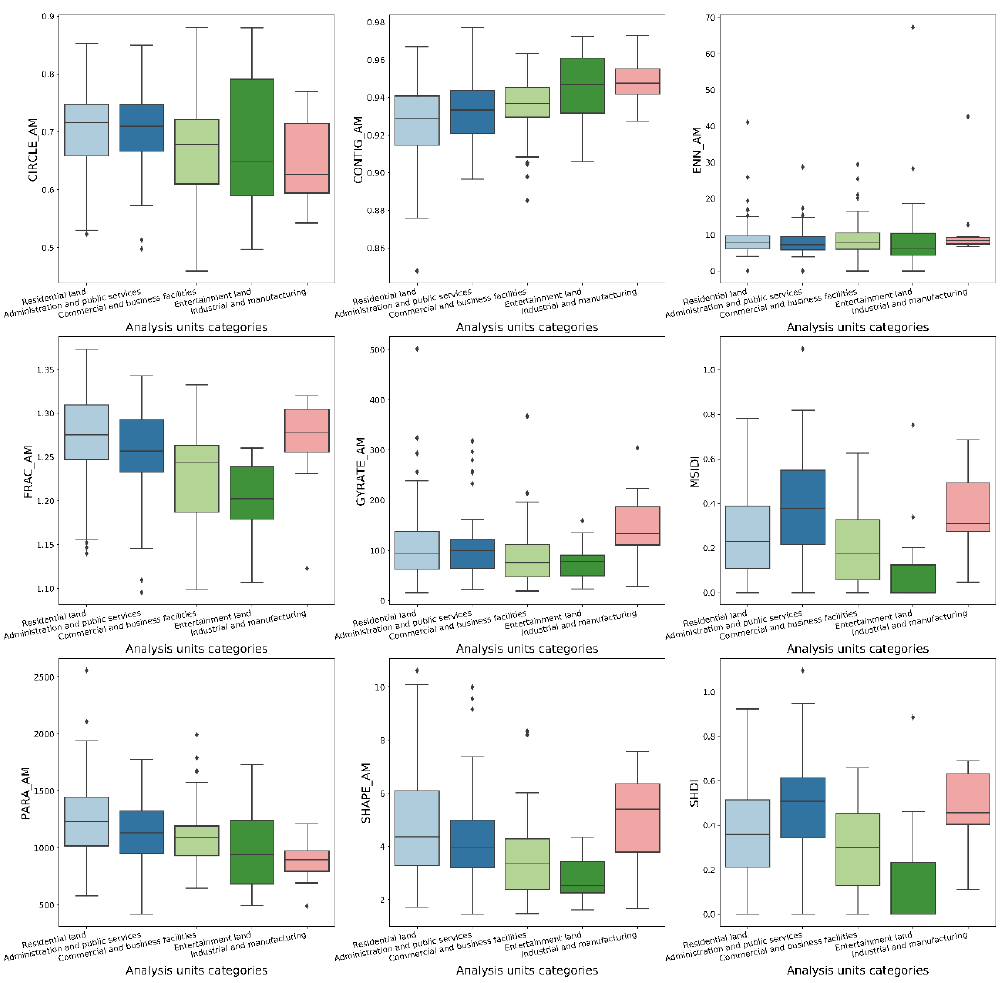
Figure 8. The boxplot visualization of landscape metrics, in turn, containing CIRCLE_AM, CONTIG_AM, ENN_AM, FRAC_AM, GYRATE_AM, MSIDI, PARA_AM, SHAPE_AM, and